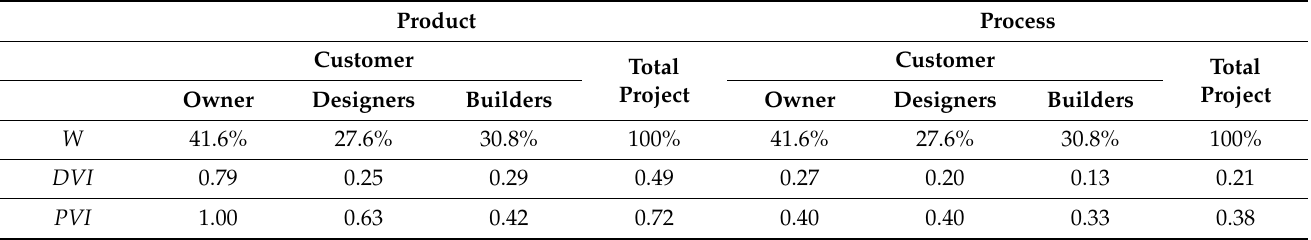
Table 7. DVI and PVI by customers and total project.